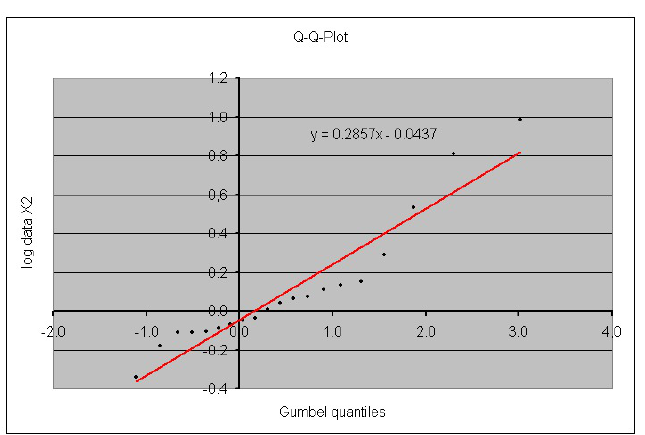
Figure 2. Q-Q-plot for the second risk, log